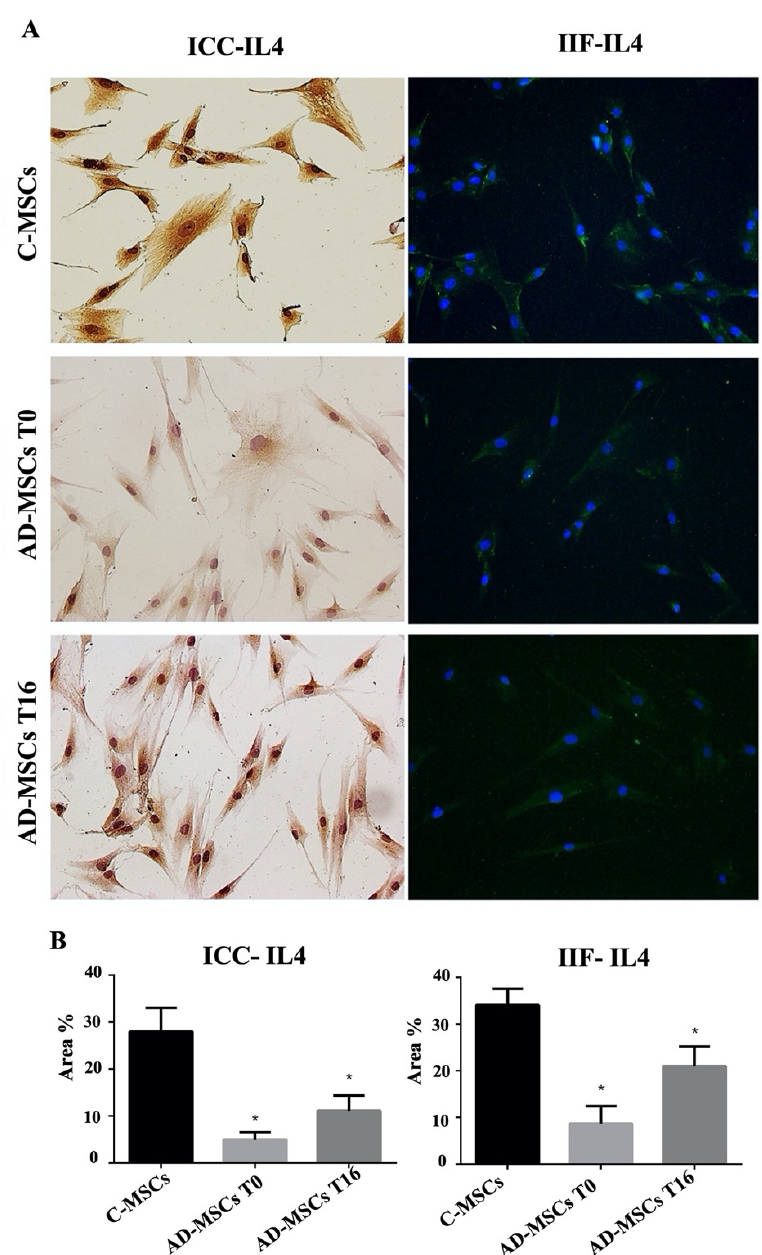
Figure 3. Analysis of the expression of IL4 by Immuno-cytochemistry (ICC) and indirect immune- fluorescence (IIF). ( A ) Representative images of IIF and ICC of IL4 on MSCs from healthy controls (C-MSCs), and MSCs from patients with AD (AD-MSCs )at T0 and at T16. For IIF, a secondary FITC-conjugated antibody was used after incubation with the primary antibodies. Nuclei were counterstained with Hoechst 33342. For ICC, slides were treated with 3,3-diaminobenzidine and counterstained with Mayer’s hematoxylin. (Scale bar: 100 µ m). ( B ) Quantification of proteins expression processed by Fiji-ImageJ. Protein expression is represented by the percentage of the area it occupies inside the cell. The * indicates significative differences of C-MSCs vs. AD-MSC (unpaired t -test; p <